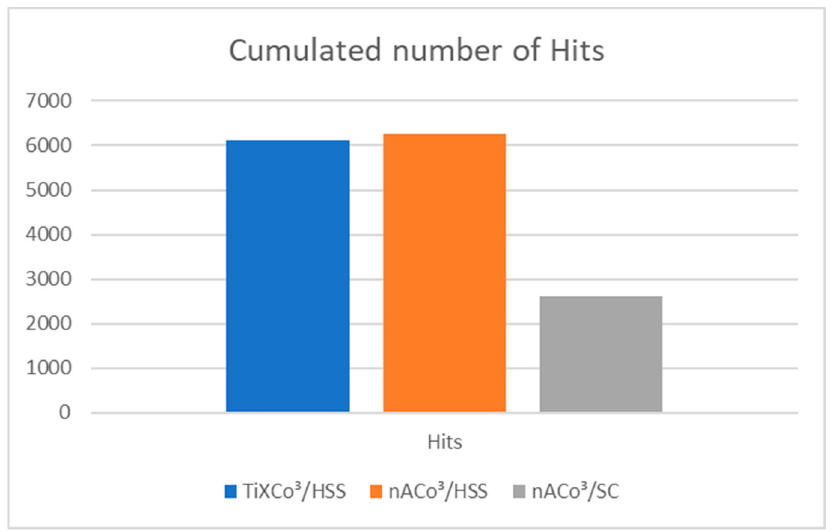
Figure 12. Cumulative number of hits.